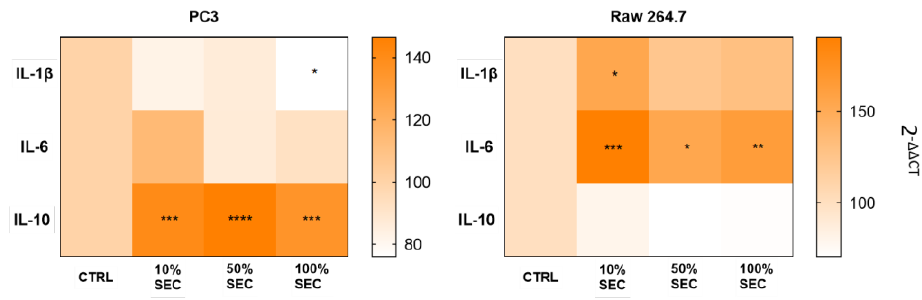
Figure 6. Gene expression of pro-inflammatory (IL- 1β and IL -6) and anti-inflammatory (IL-10) cytokines in the PC3 and RAW264.7 cell lines supplemented with 10%, 50%, and 100% of the adipocyte secretome. The results were compared with the CTRL condition (cells cultured with medium without any serum) that was normalized to 100%. p values of <0.05 were considered to be statistically significant: * means p < 0.05; ** means p < 0.01; *** means p < 0.001 and **** means p < 0.0001.